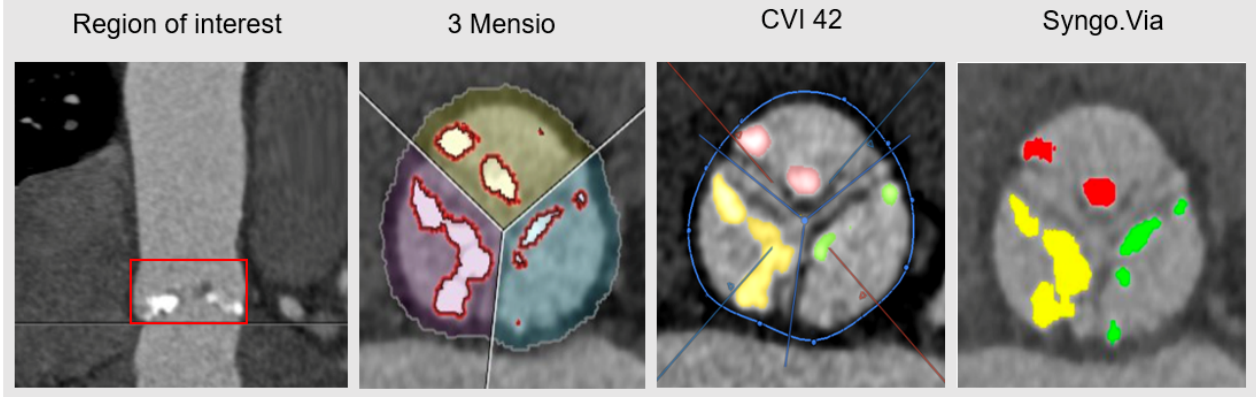
Figure 1. Visualisation of Aortic Valve Calcification. A representative illustration of the region of interest (coronary view) and of the aortic valve (transversal view), using the different software types. Aortic valve calcification is marked and differently colour coded for the aortic cusps, respectively.